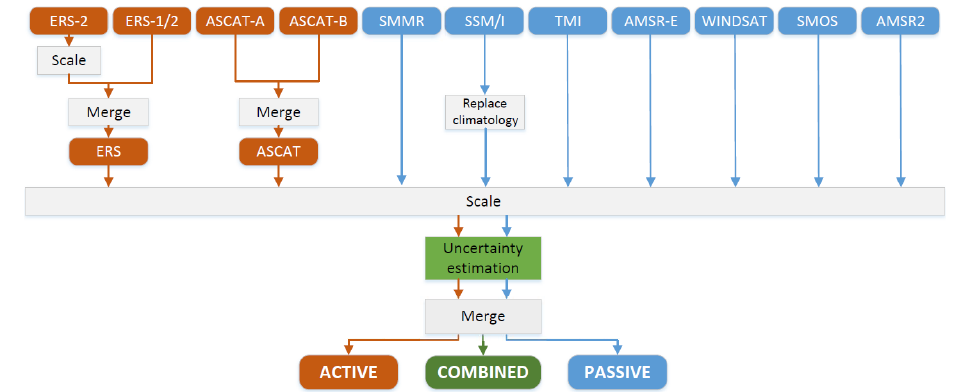
Figure 5. Merging scheme of the ESA CCI SM v4